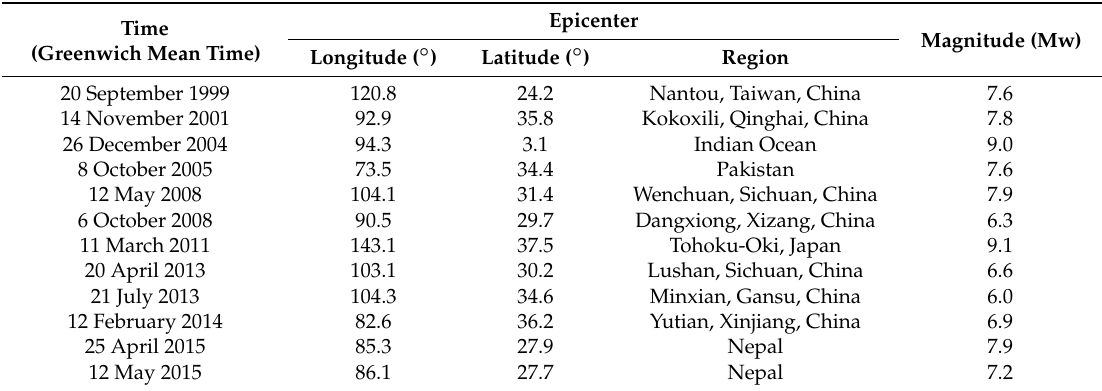
Table A2. Three-dimensional velocity estimates and their uncertainties of the CMC filtered 231 CMONOC stations estimated with the PLN + WN model. The reference frame is IGb08. Station